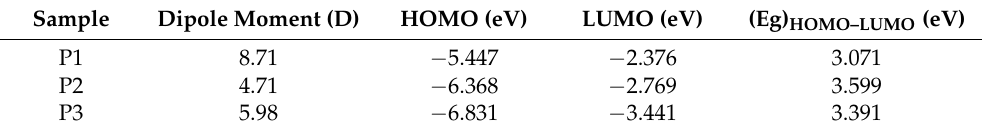
Table 3. Dipole moment, HOMO and LUMO energy levels and theoretical bandgap ((E g ) HOMO–LUMO ).